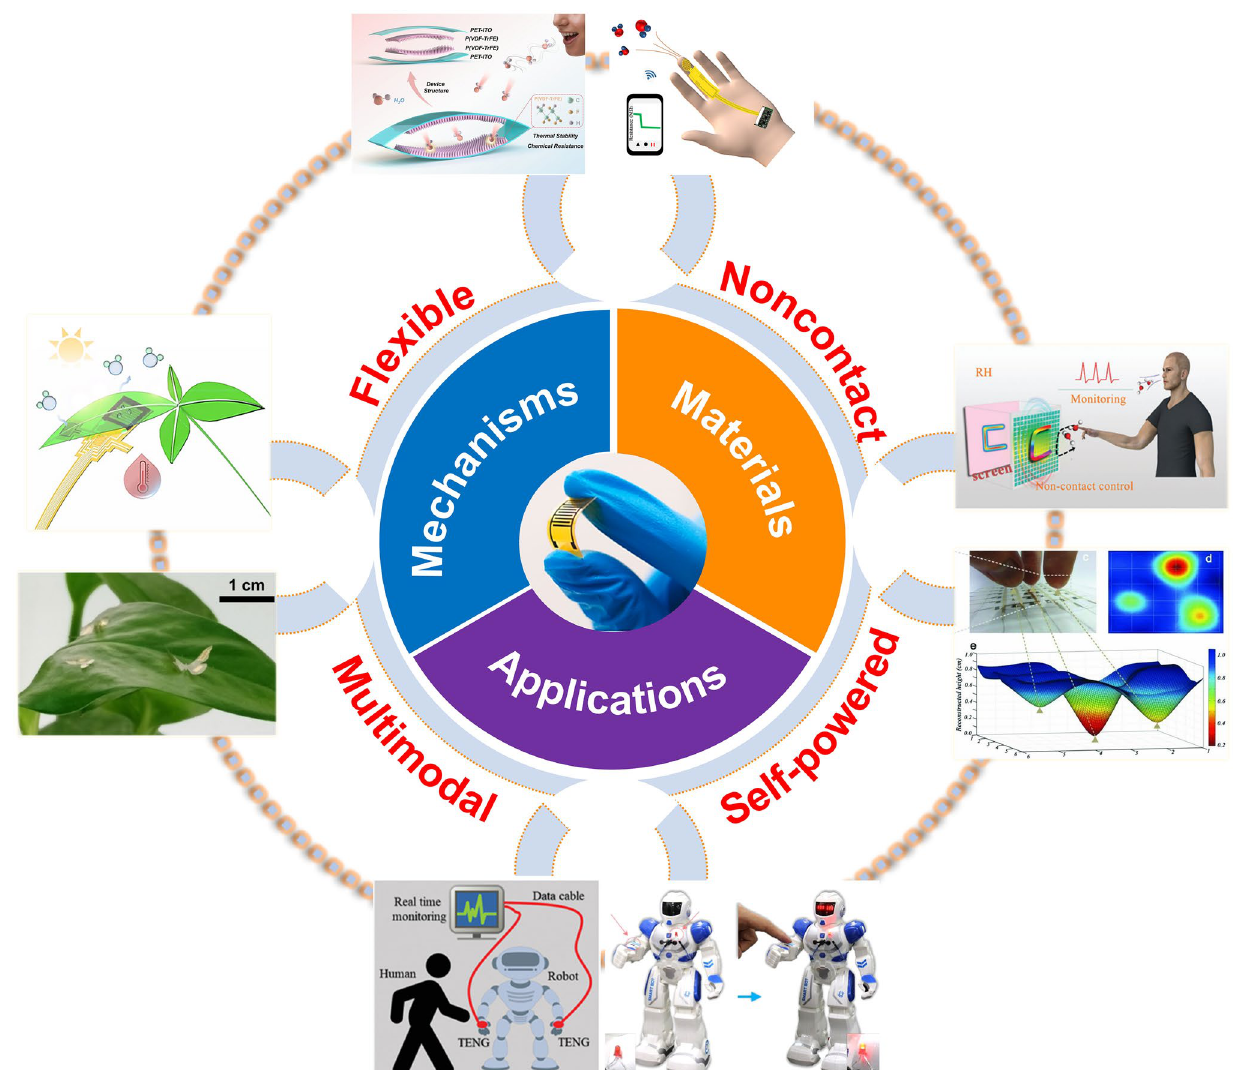
Fig. 1 An overview of the multifunctional humidity sensors. Flexible capacitive humidity sensing system based on arc-shaped hollow struc- ture [74]. Copyright 2021 Elsevier. Wireless finger moisture application [46]. Copyright 2021 Royal Society of Chemistry. Schematic diagram of a flexible humidity sensing system, including noncontact control and humidity monitoring [50]. Copyright 2012 Wiley. Flexible humidity sensor arrays for skin moisture mapping [100]. Copyright 2019 Wiley. The IPMEC attached on a robot as artificial skin for the detection of an approaching finger [169]. Copyright 2017 Elsevier. Schematic application of obstacle sensor in the robot for avoiding human objects [35] Copy- right 2021 Wiley. Butterfly shaped sensory platform on a leaf [184]. Copyright 2018 Nature. Multimodal plant healthcare system [44].